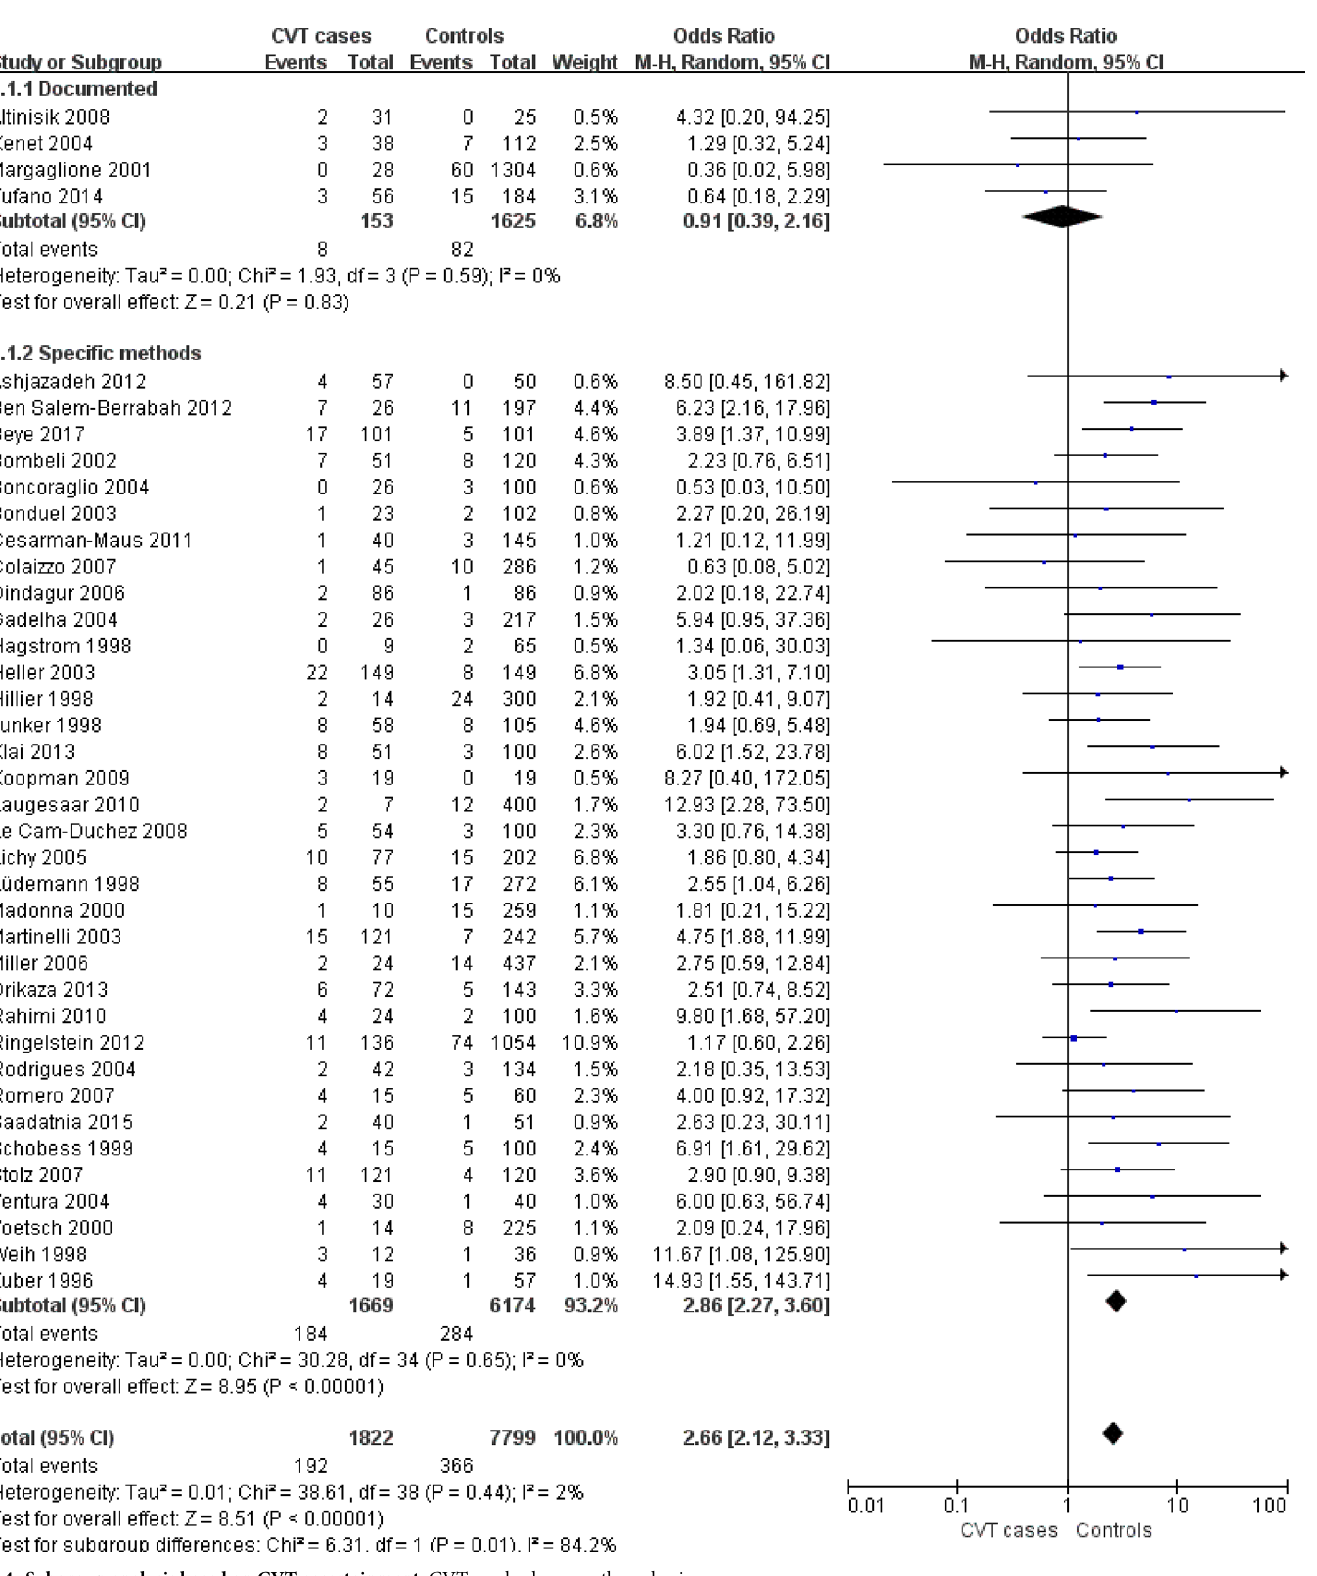
Fig 4. Subgroup analysis based on CVT ascertainment. CVT,cerebral venous thrombosis.